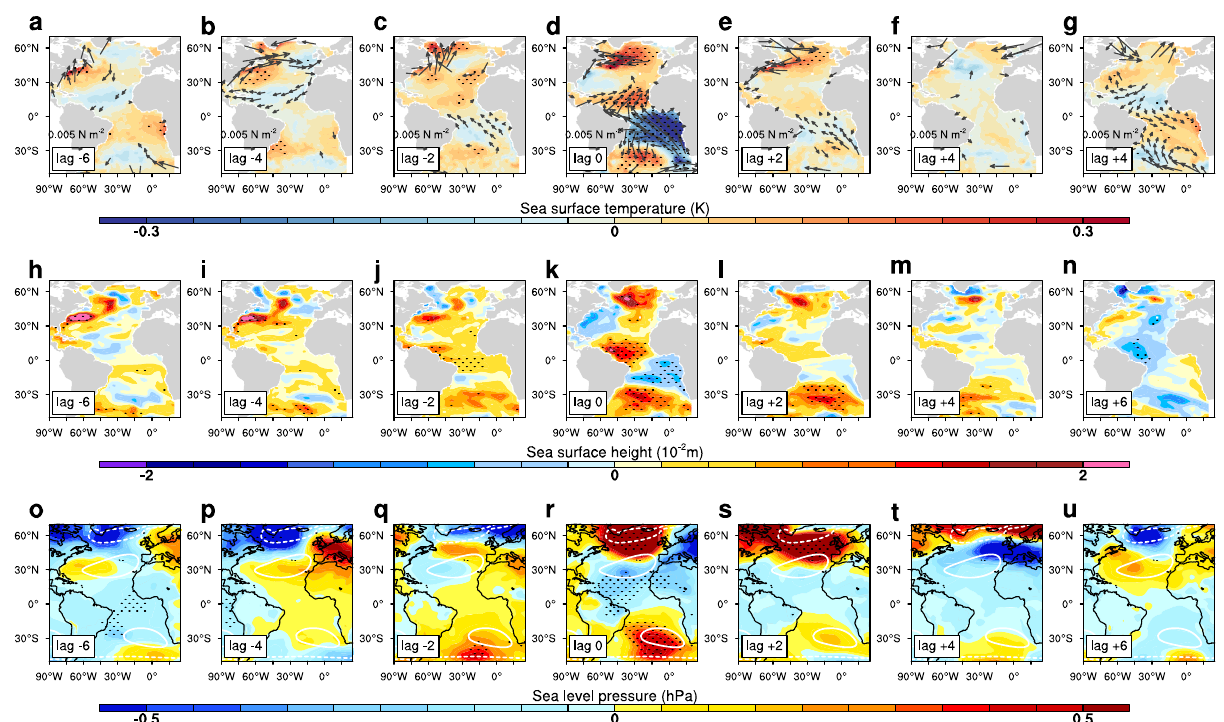
Fig. 4 Evolution of the related air – sea interactions. a – g Anomalies of the SST (colour-scale) and wind stress (arrows, only statistically signi fi cant vectors are shown), ( h – n ) sea surface height and ( o – u ) sea level pressure lag-regressed on the SST PC2. In all panels, stipples denote statistical signi fi cance at 95% con fi dence level. In ( o – u ), the white contours show regions of mean annual high pressure (1018 hPa, solid) and low pressure (1008 hPa, dashed). Panels ( a – n ) ( o – u ) are based on annual (December – February)